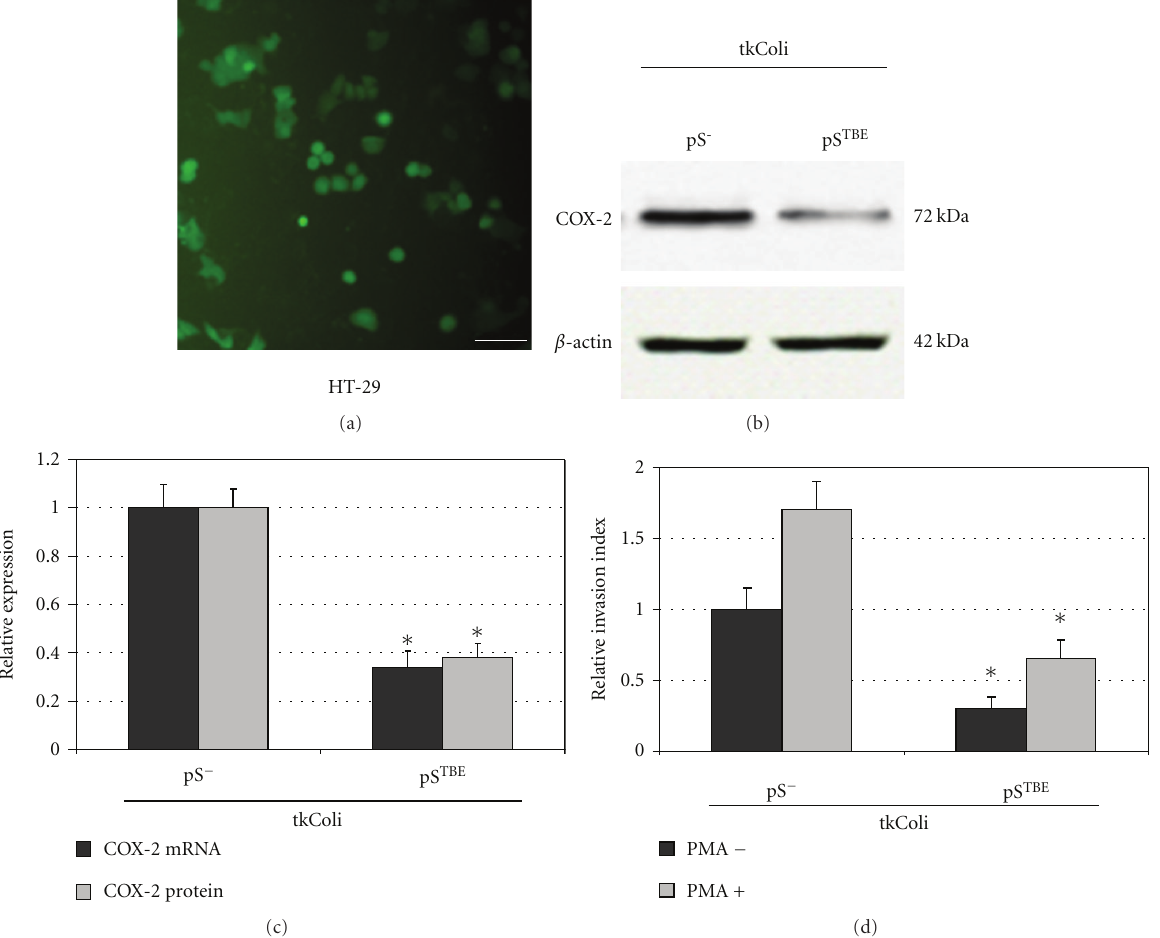
Figure 2: Invasive tkColi infect CRC HT-29 cells and promote high COX-2 silencing associated with a reduced invasive behavior. E. coli was cotransformed with pGB2- Ω -inv-hly plasmid and pSUPER.retro vectors to obtain E. coli invasive strains carrying the shCOX-2 expression vector tkColi-pSTBE (in which shCOX-2 expression is controlled by TBE promoter carrying Tcf Binding Elements). The negative control was tkColi-pS-(not expressing shCOX2 but containing the original empty pSUPER.retro vector). GFP protein expression (a) was used to evaluate the e ffi ciency of tkColi infection of HT-29 cells (bar = 30 μ m). 72 hours after the infection, the e ffi ciency of infection was higher than 75%. The expressions of COX-2 protein and COX-2 mRNA were analyzed in HT-29 cells, 72 hours after tkColi infection, by Western blot and real- time PCR (c). COX-2 protein and COX-2 mRNA expressions were normalized against β -actin protein and GUSB ( β -glucuronidase) mRNA levels, respectively. Relative expression of COX-2 protein and COX-2 mRNA refers to tkColi-pS-infected sample. The invasive behavior of tkColi infected CRC HT-29 cells was evaluated by using Boyden chambers and 8- μ m polycarbonate membranes coated with Matrigel. Samples were tested in the absence (dark bars) and in the presence (light bars) of PMA 40 nM. Relative invasion index refers to HT-29 cells infected with tkColi-pS-, not treated with PMA. Data reported in (b)–(d) represent the mean ± SEM of three independent experiments; ∗ P < .